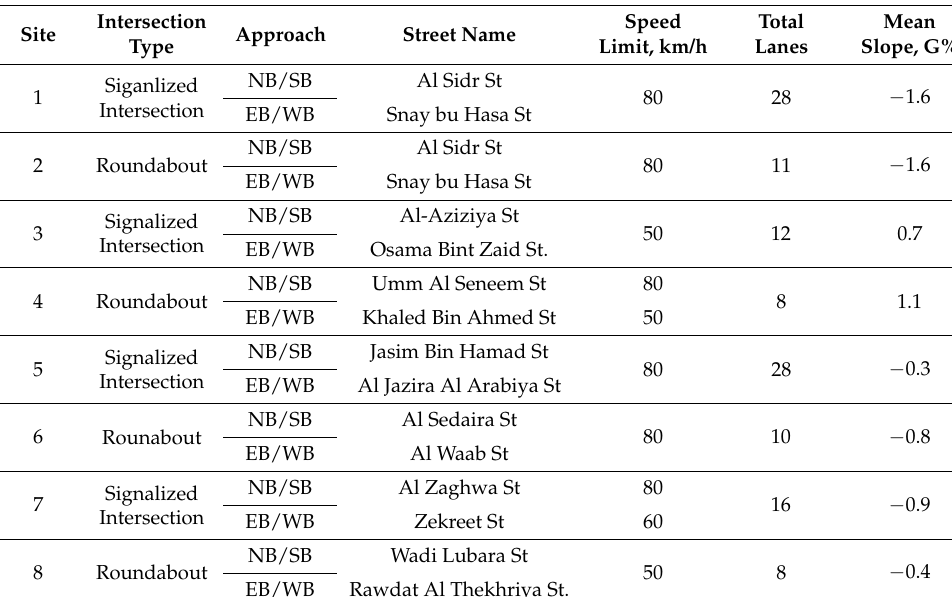
Figure 1. Site locations of the study intersections. Table 3. Characteristics of the study